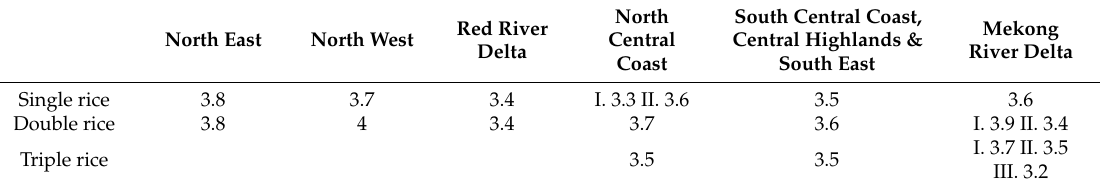
Table 2. Thresholds of DTW distance applied to multi-cultivated rice in each